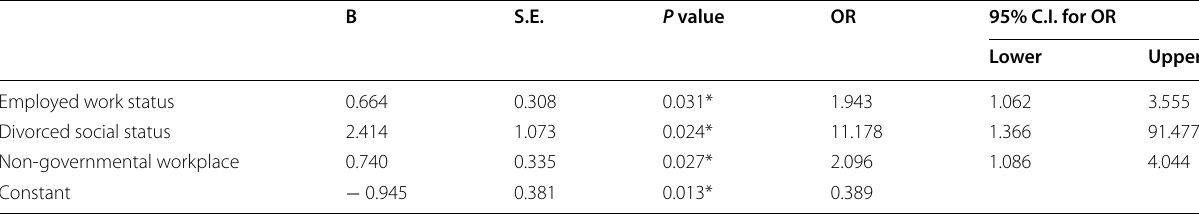
*Statistically significant at p value < 0.05